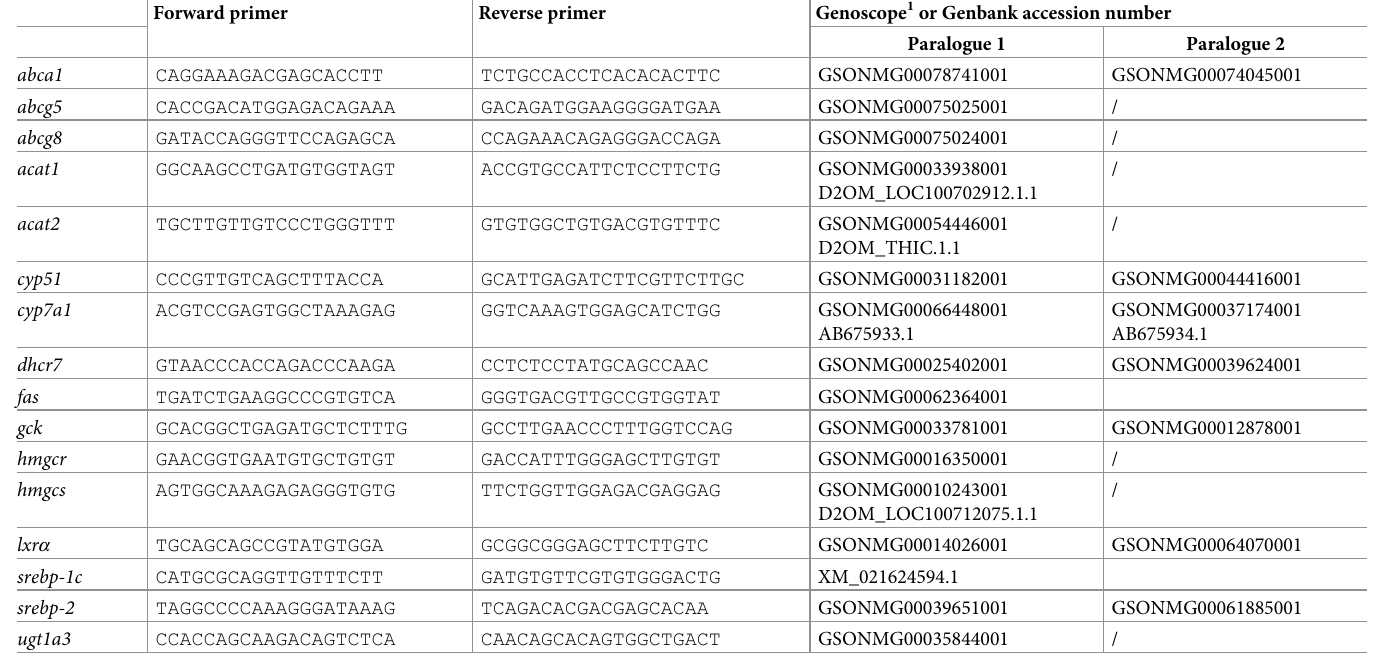
Table 1. Sequence of the primers in qRT-PCR for gene expression analysis. Forward